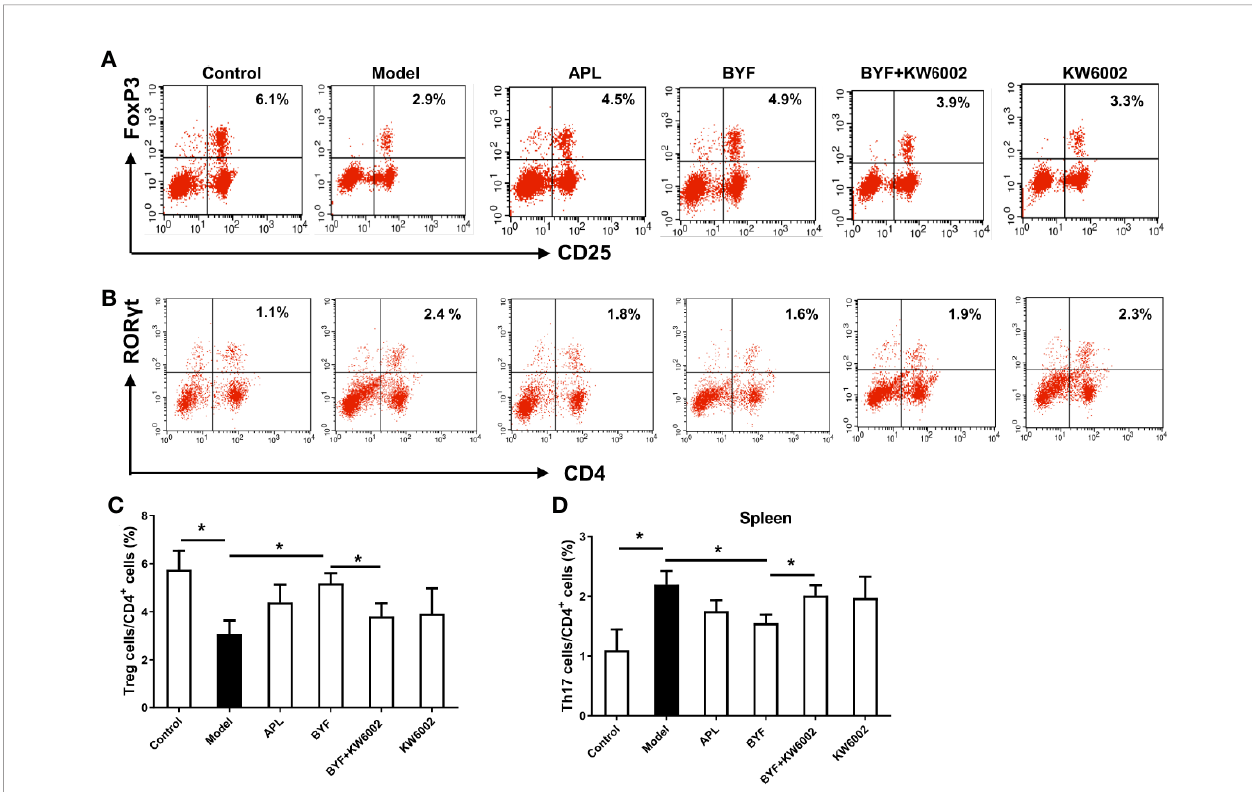
FIGURE 6 | Effect of cotreatment of Bufei Yishen formula (BYF) and A2aR antagonist on the balance of Th17/Treg cells in spleens of chronic obstructive pulmonary disease (COPD). COPD rats were orally administrated with BYF, KW6002 and aminophylline. The proportion of Treg (A) and Th17 cells (B) was detected. Statistics of the proportion of Treg (C) and Th17 cells (D) were analyzed. The values are presented as the means ± SEM (n=6 mice per group). *P <